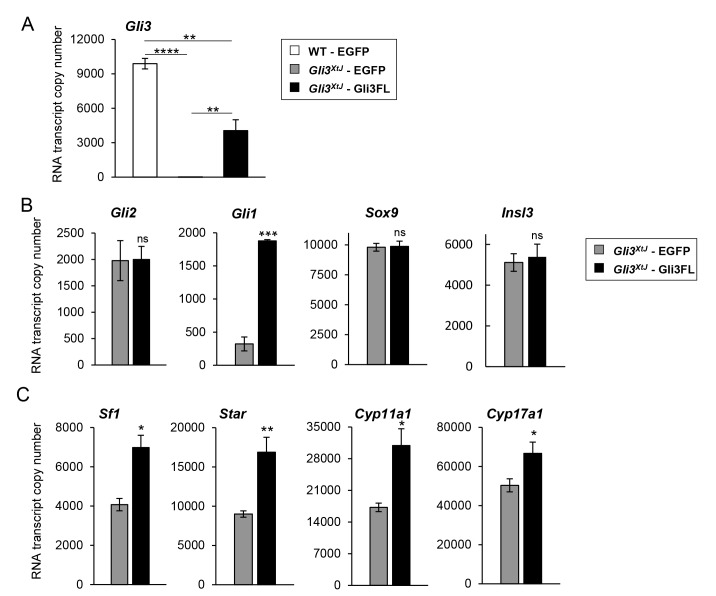
Reintroduction of pGli3FL plasmid DNA restored expression of steroidogenic genes.A) Wild type and Gli3XtJ mutant testes were transiently transfected with pEGFP-C2 or pEGFP-Gli3FL plasmids and transfection efficiency was analyzed by quantifying the transcript numbers of Gli3 using copy number qPCR. Results are represented as mean ± SEM from n = 3–4 biological replicates. One-way ANOVA followed by post-hoc Tukey’s test, **: p<0.01, ****: p<0.0001. B,C)
Gli3XtJ mutant testes were transiently transfected with pEGFP-N1 (gray bars) or pEGFP-Gli3FL (black bars) plasmids. Transcript numbers of Gli2 and Sox9 (negative controls), Gli1 (positive control), Insl3 (B), and steroidogenic genes (C) were measured in the transfected testes. Results are represented as mean ± SEM from n = 3–4 biological replicates. Student’s t-test, *: p<0.05, **: p<0.01.